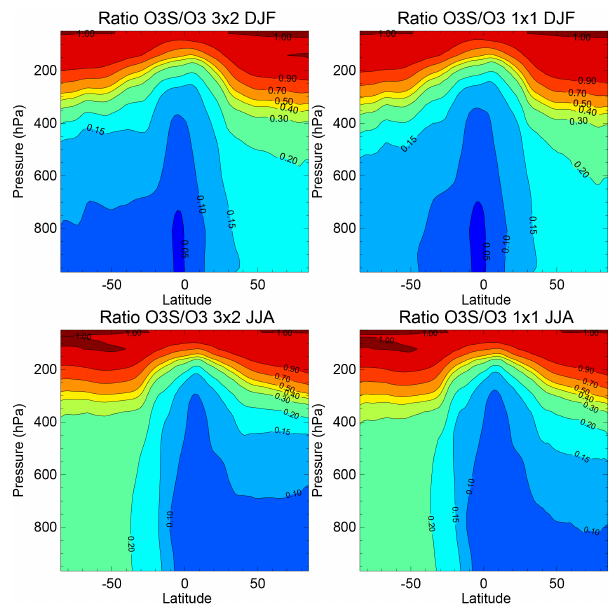
Figure 2. Zonal mean seasonal distribution of the TM5-MP O 3 S / O 3 ratio for the 3 ◦ × 2 ◦ (left) and 1 ◦ × 1 ◦ (right) simulations.